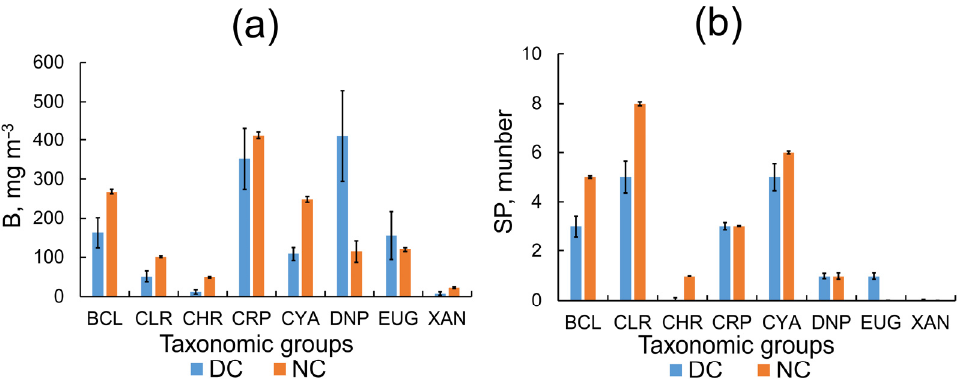
Figure 3. Average biomass ( a ), and species richness ( b ) of various algae groups with standard deviation (black bars) at the station during the periods of construction of new port facilities (DC) and in their absence (NC) in the Neva Estuary in the 2000s. DC—averaged values for all stations for 2006–